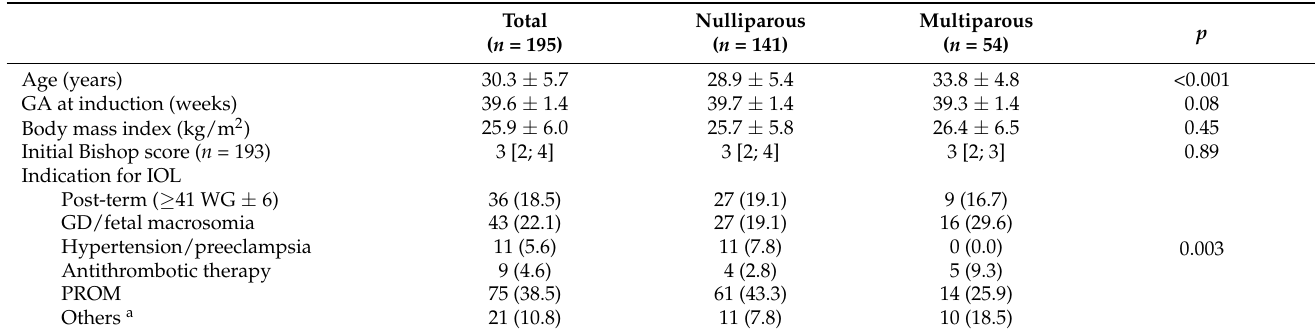
Table 1. Demographic and clinical maternal baseline data.